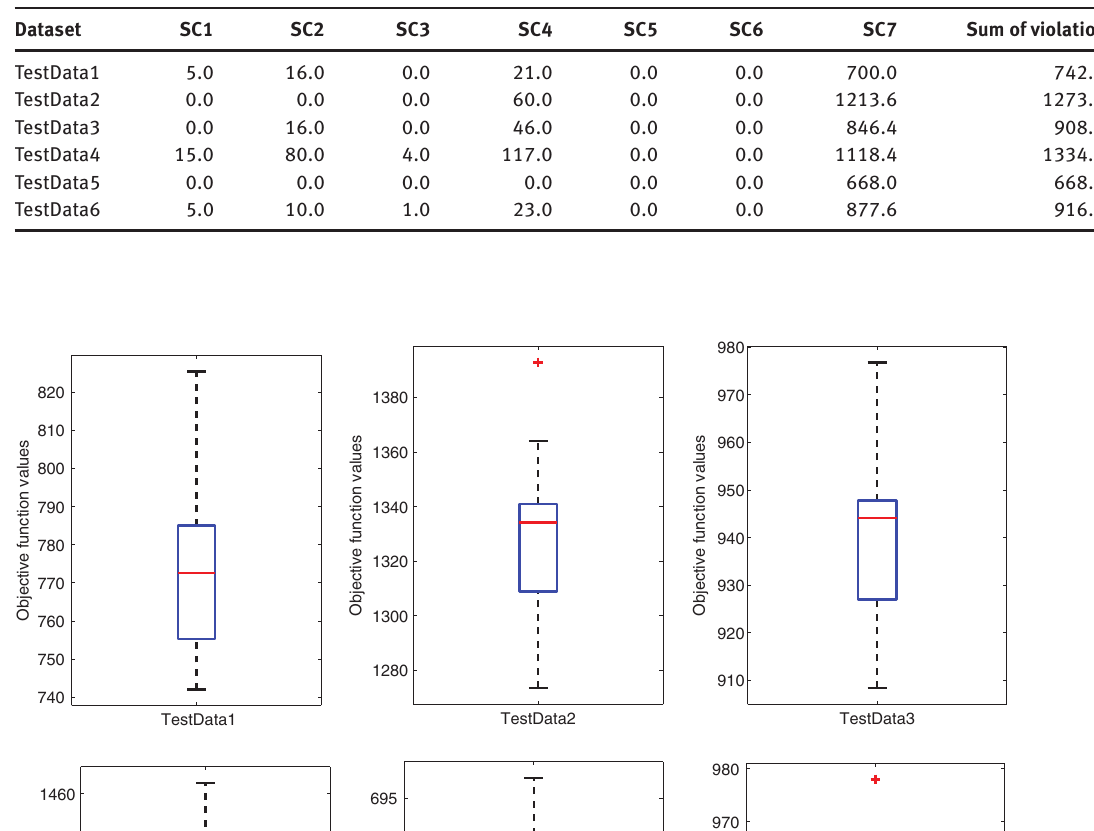
Table 9: The Violations of Soft Constraint of Best Solutions